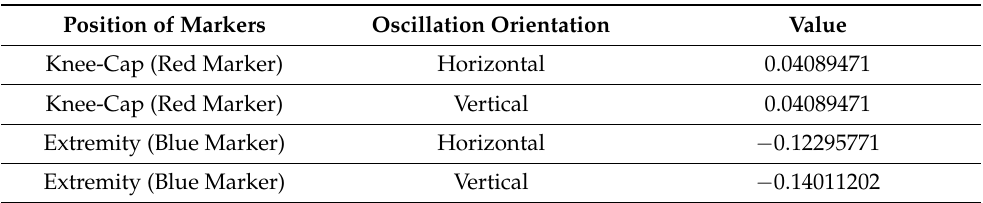
Table 1. Pearson correlation values between markers and the kneecap to extremity distance with static probe in minimal position.